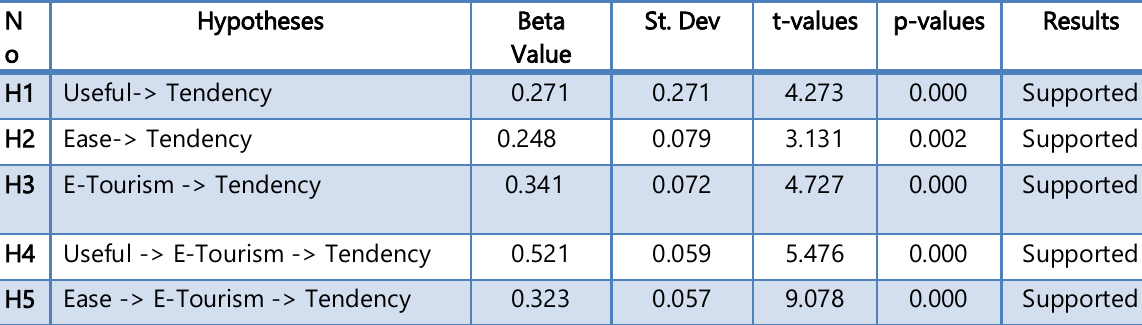
Figure 2: Structural Equation Model (Source: Authors‘ depiction) Table 4: Direct Effect and Indirect Effect (Source: Authors‘ depiction)